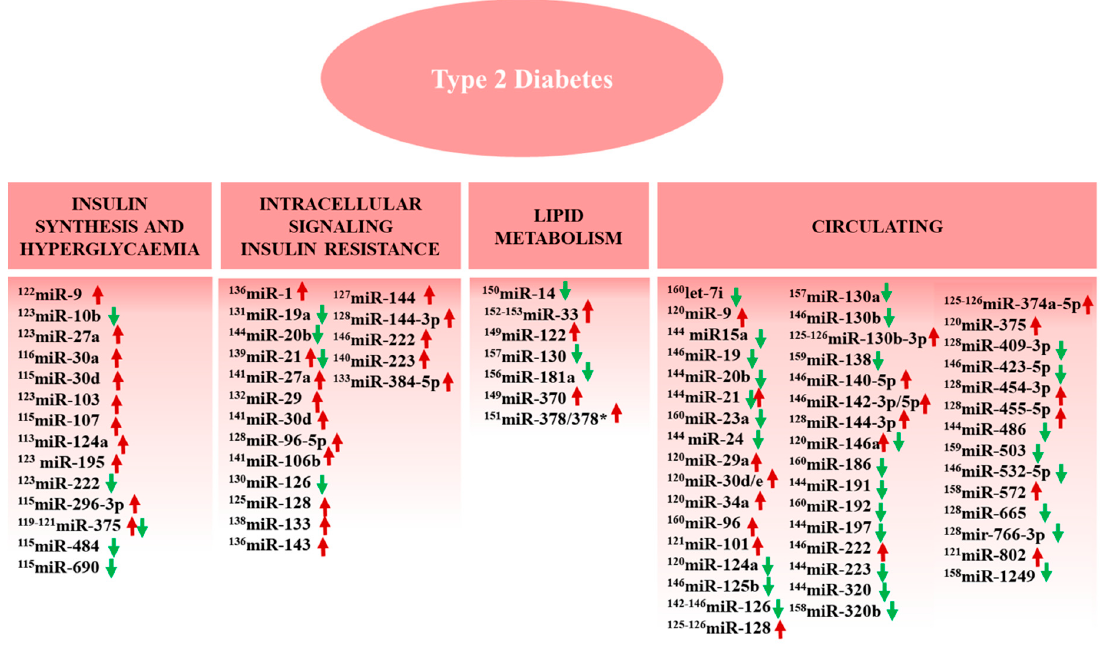
Figure 2. The dysregulated miRNA profile in Type 2 Diabetes. The diagram shows the miRNA expression pattern associated with different pathophysiological mechanisms involved in type 2 Diabetes, including insulin synthesis, intracellular signaling/insulin resistance, lipid metabolism, and hyperglycemia. Circulating miRNAs evaluated in serum, plasma, whole-blood, or mononuclear cells, in clinical studies, are also listed. ↑ = upregulated, ↓ = downregulated, ↑↓ = studies differ and report either increased or decreased expression of the miRNA.